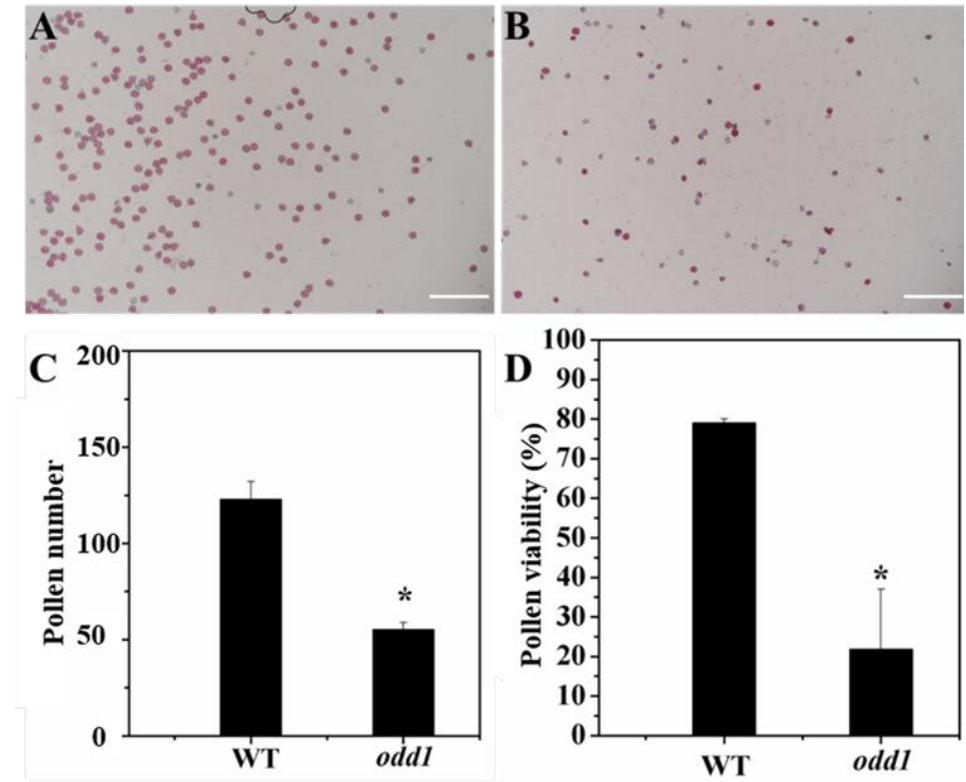
Figure 10. Pollen quantity and vitality of WT and odd1 . ( A , B ) Pollen viability of WT and odd1 . ( C ) The respective quantifications of pollen number in a single field of view. ( D ) The respective quantifications of vital pollen grains. Asterisk indicates significant differences (single asterisk, p = 0.05). The bars in C and D represent the standard deviation (n = 6). Scale bars represent 200 μm.